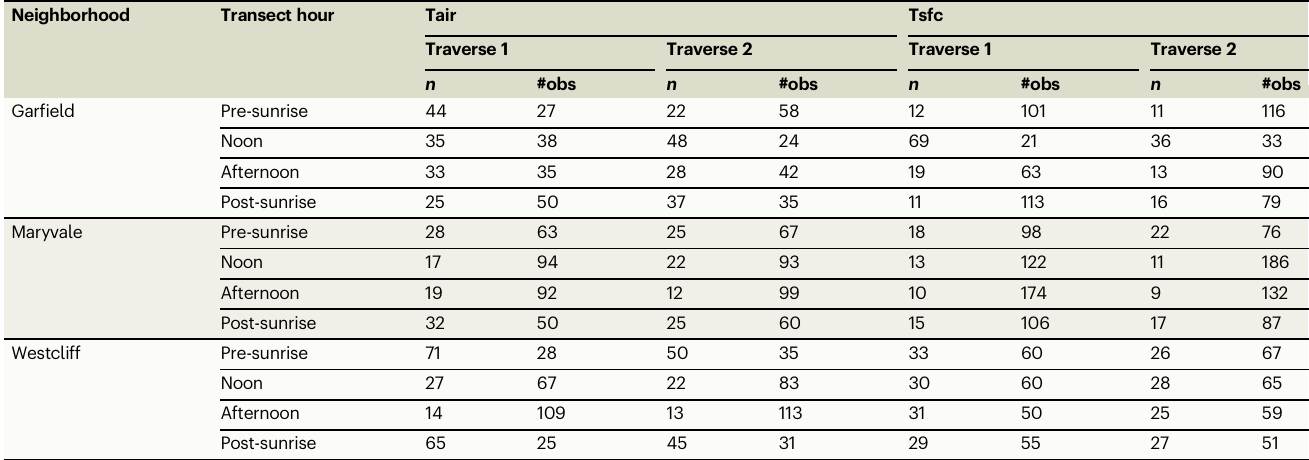
Table2|N-thobservation “ n ” andtheresultingnumberofobservations “ #obs ” thatcouldbeusedinstatisticalanalysistoavoid autocorrelation for each neighborhood, transect hour, and car-derived heat metric